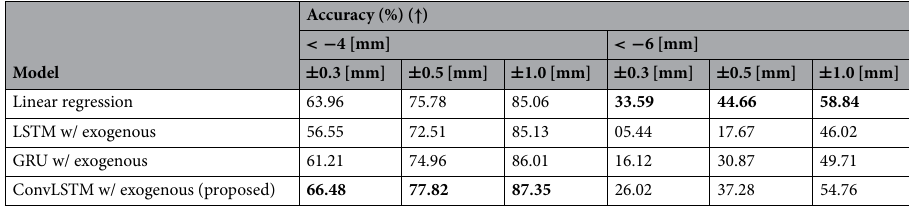
Table 7. Comparison results of the accuracy. The accuracy is calculated for each method with tolerance ε = 0.3, 0.5, 1.0 [mm] on the data with the evaluation threshold levels α = − 4, − 6 [mm]. Significant values are in